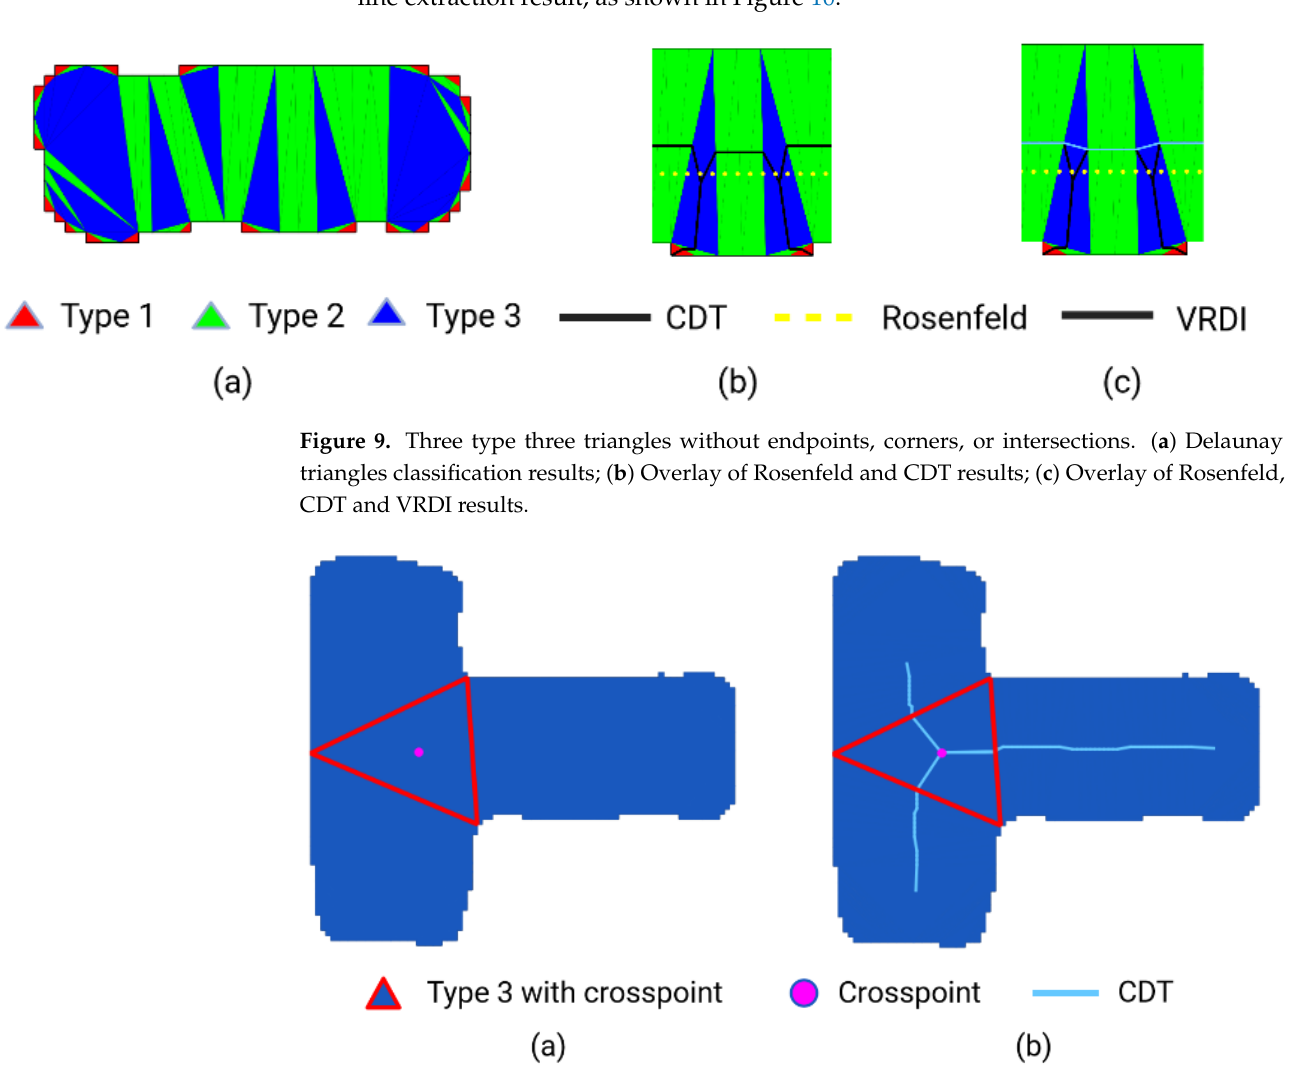
Figure 10. Traditional CDT method for type three triangle connections with a crosspoint. ( a ) Building with crosspoint; ( b ) Result of traditional CDT method.